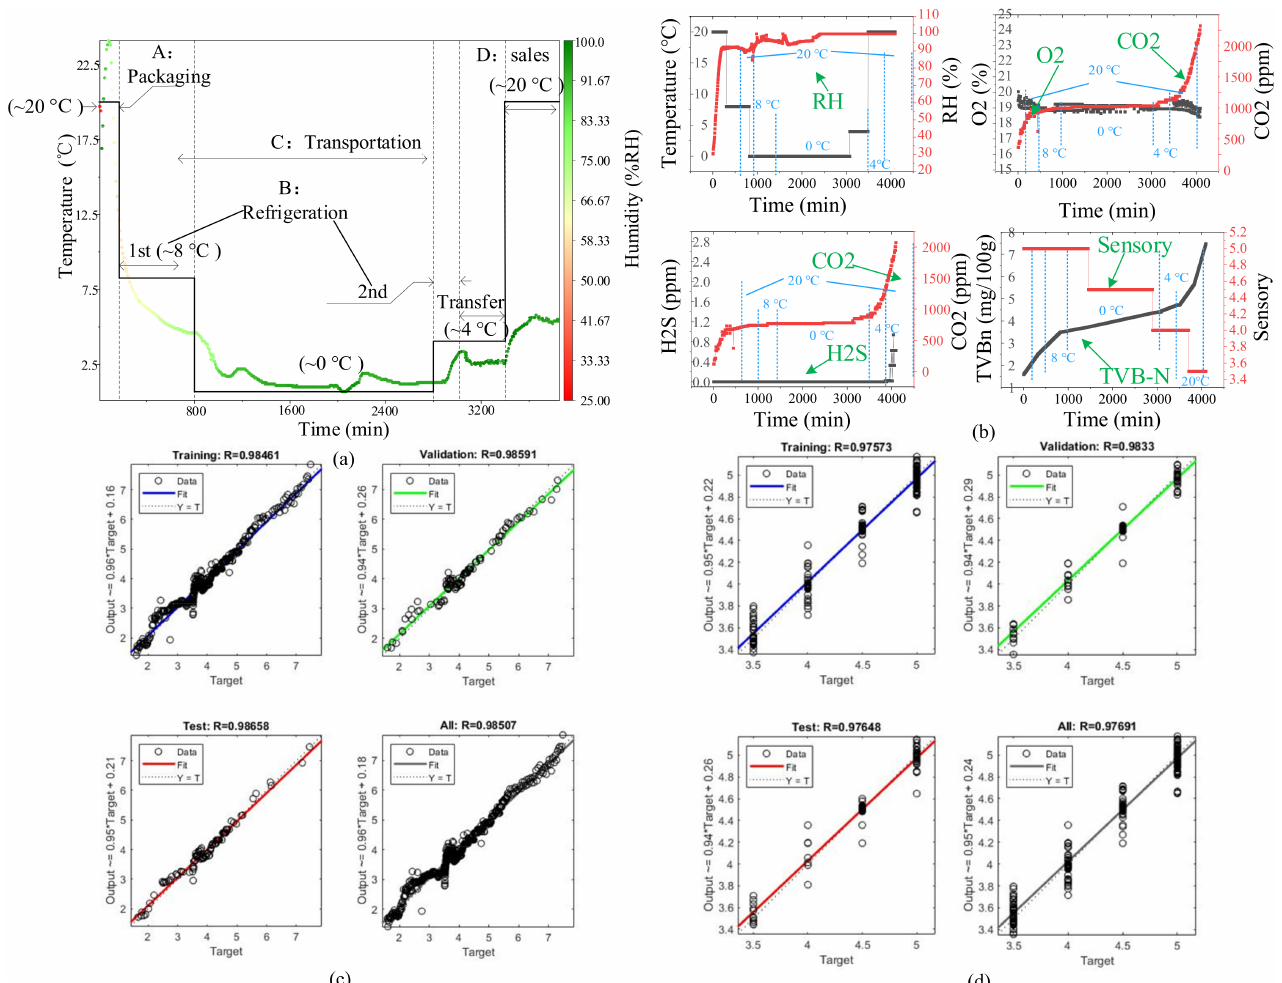
Figure 8. The actual cold chain of chilled chicken and simulation verification. ( a ) Actual cold chain; ( b ) Critical parameters and indicators change; ( c ) TVB-N prediction verification; ( d ) Sensory evaluation prediction